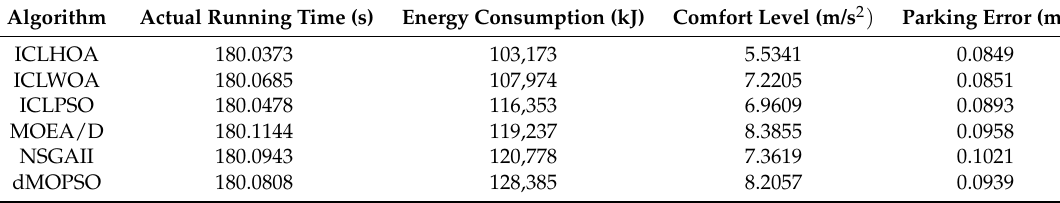
Table 4. Optimization results of velocity ideal trajectory profile obtained by different algorithms in